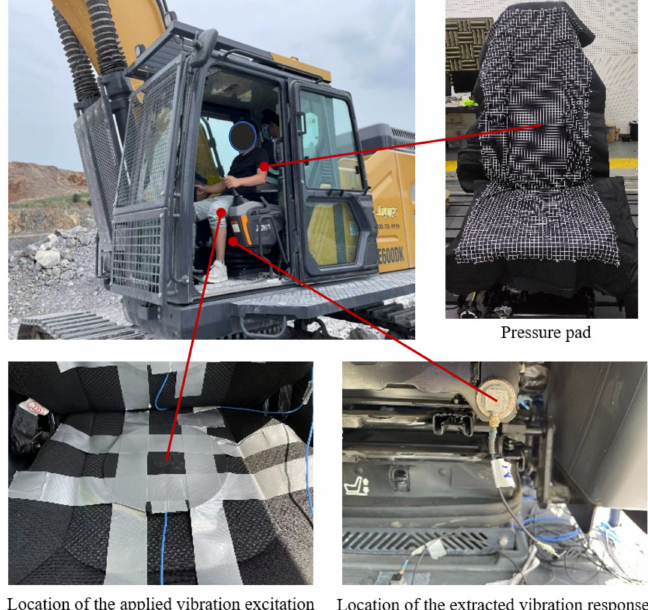
Figure 6. Body pressure distribution test and vibration response